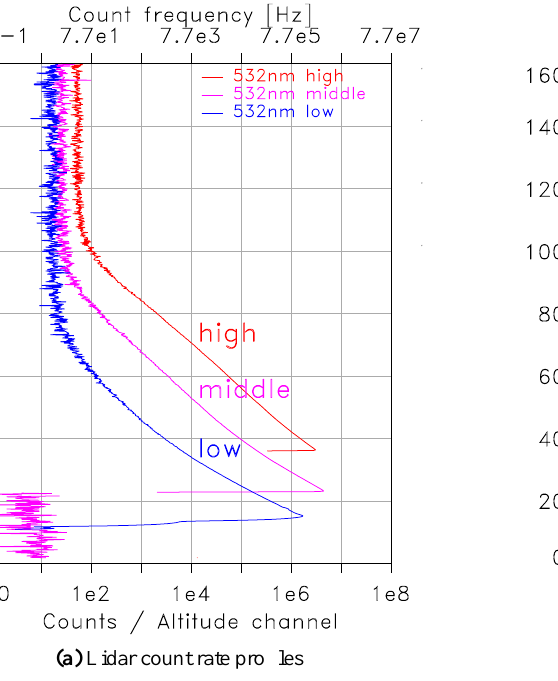
Fig. A2. Left panel: Raw data profiles from the three intensity-cascaded channels at 532nm after summation for the RMR lidar measurement on 13 February 2005 17UT–5UT (1292000 laser pulses). The lower end of the profiles is given by the electronic gating of the detectors. The upper scale gives the equivalent count rate for the detectors. Note the exponential scale on the x-axis. Right panel: Adjustment factors for detector dead-time, extinction by air and ozone and the viewing geometry of the lidar (see text for